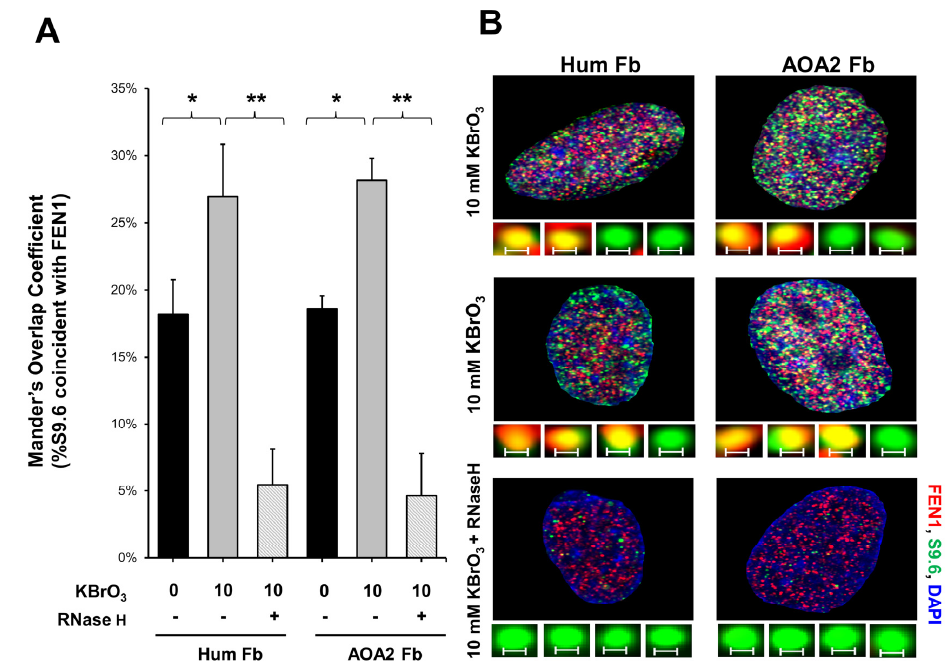
Figure 4. FEN1 recruitment to R-loops in human fibroblasts following oxidative DNA base damage. ( A ) The Mander’s Overlap Coefficient (percentage of the anti-R-loop antibody, S9.6 signal that overlaps with FEN1) indicated that the colocalization of R-loops and FEN1 (FEN1 recruitment to R-loops) increased after oxidative DNA damage (10 mM KBrO 3 treatment for 75 min) in both normal human fibroblasts and in senataxin deficient AOA2 fibroblasts. Error bars are standard error of the mean. “*” and “**” indicate statistical significance ( p < 0.05 and p < 0.005, respectively from Student t -test, 2 tailed, homoscedastic). ( B ) Representative images of nuclei of both cell types, either treated or non-treated in the presence of absence of RNase H and of (insets) non-colocalized (green) and colocalized (yellow) foci of FEN1 (red) and S9.6 (RNA-DNA) (green). Scale bar = 0.2 µm.